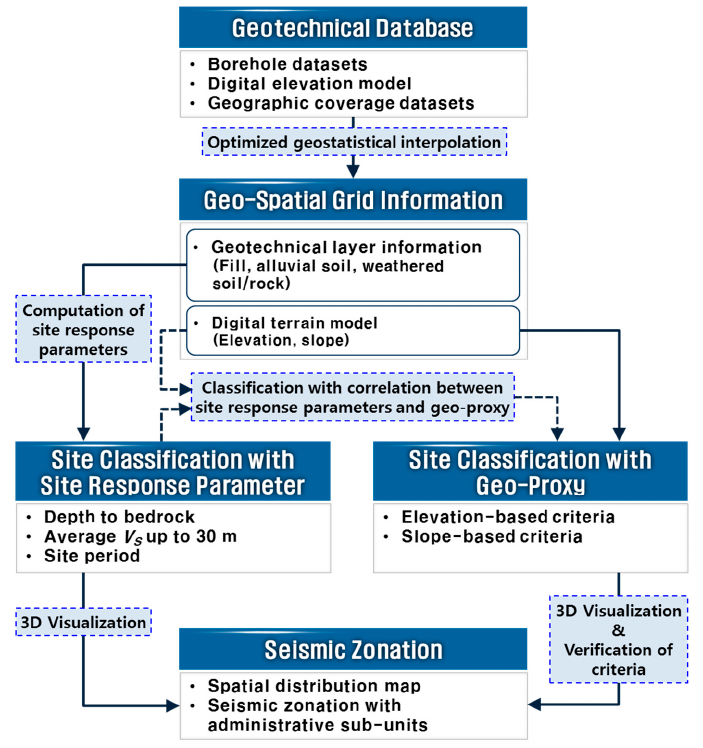
Figure 1. Dual framework for site classification system with site response parameters and